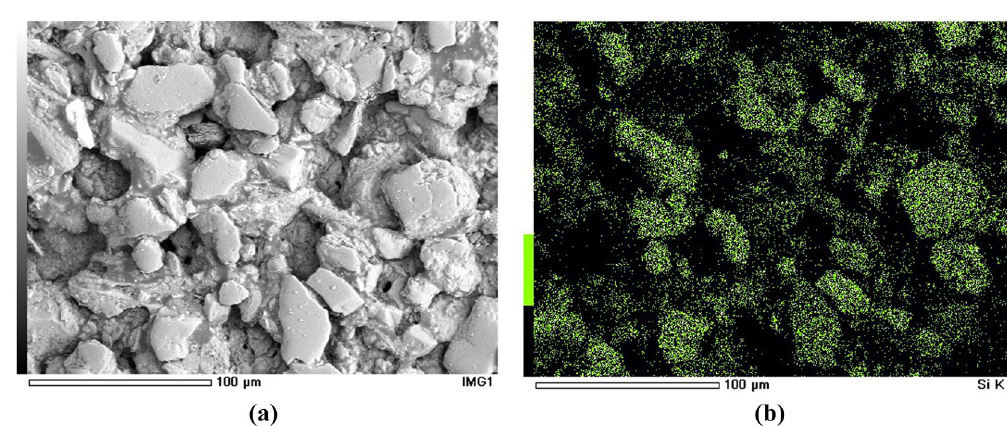
Figure 4. Energy spectrum map and surface scan image: ( a ) Energy spectrum map; ( b ) Surface scan